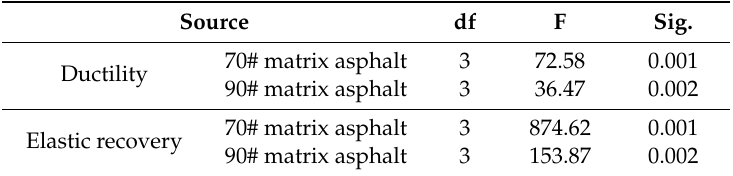
Table 5. Variance analysis result of ductility and elastic recovery for SBS modified asphalt.